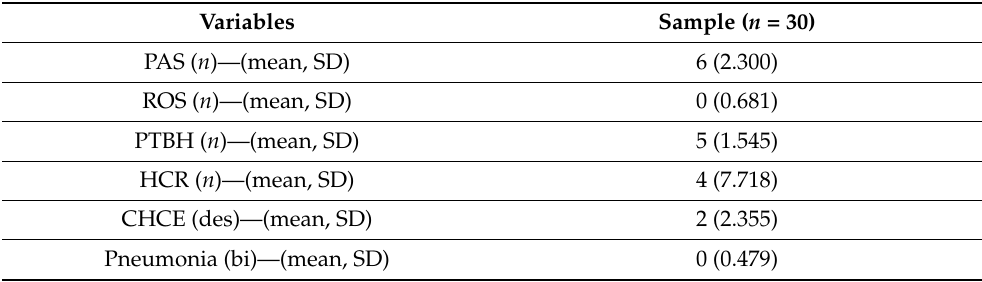
Table 2. Results for descriptive statistics for PAS, ROS, PTBH, HCR, CHCE, and pneumonia.